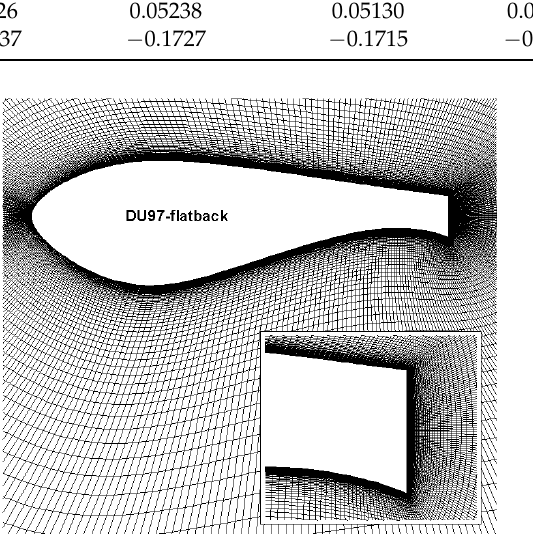
Figure 5. Computational grid of a DU97-Flatback airfoil with close-up of the trailing edge.